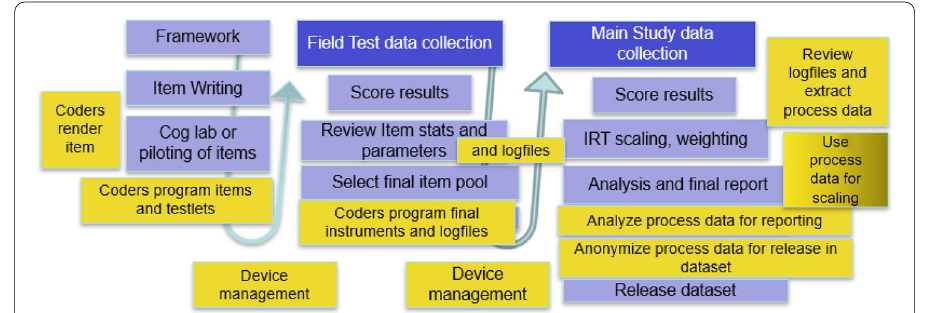
Fig. 4 Assessment system processes with DBA. Graphical representation of an assessment system’s processes, from test development through system operationalization, with new steps that are the byproducts of the shift to DBA. Author’s own